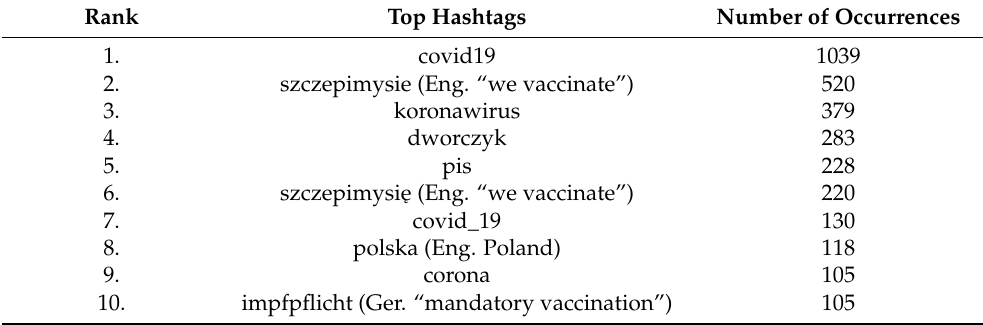
Table 1. Top 10 hashtags in the group G1.